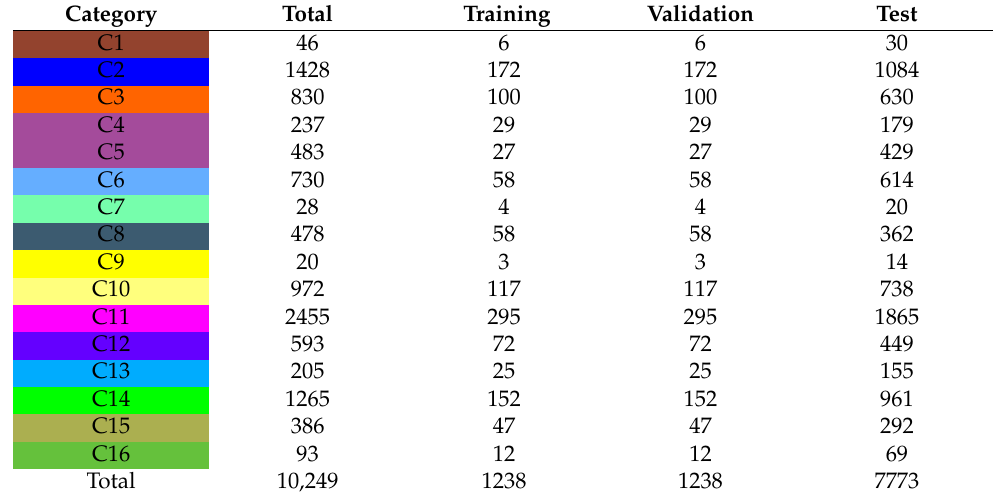
Table 3. Category information and corresponding experimental sample size for